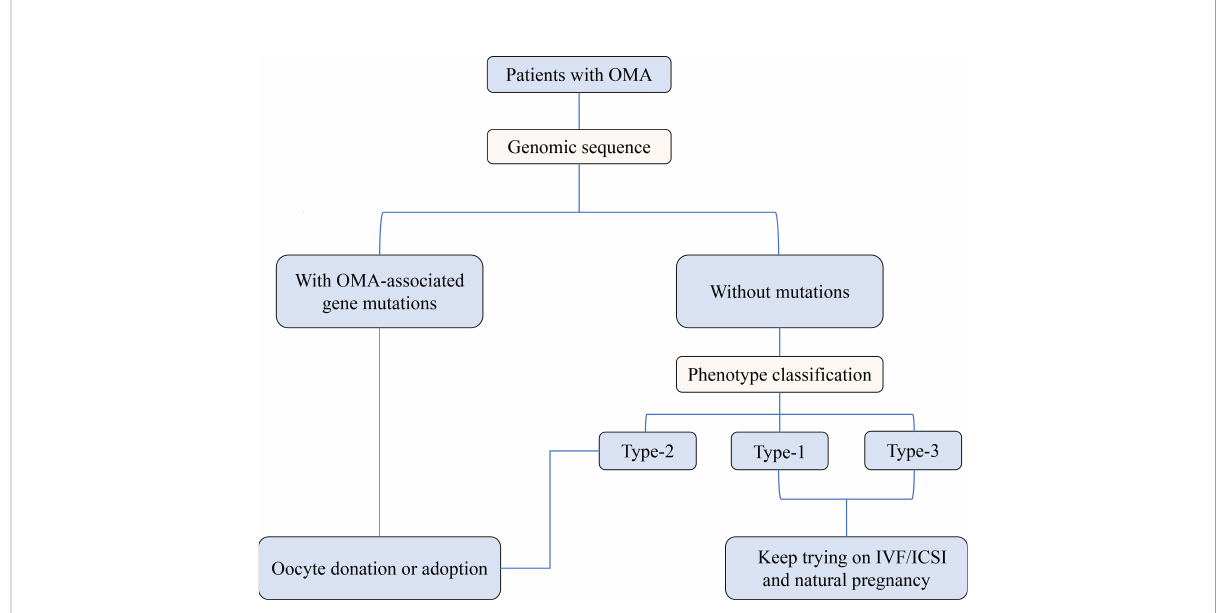
FIGURE 1 Preliminary triage system for patients with OMA based on the genetic analysis and oocyte phenotype classi fi